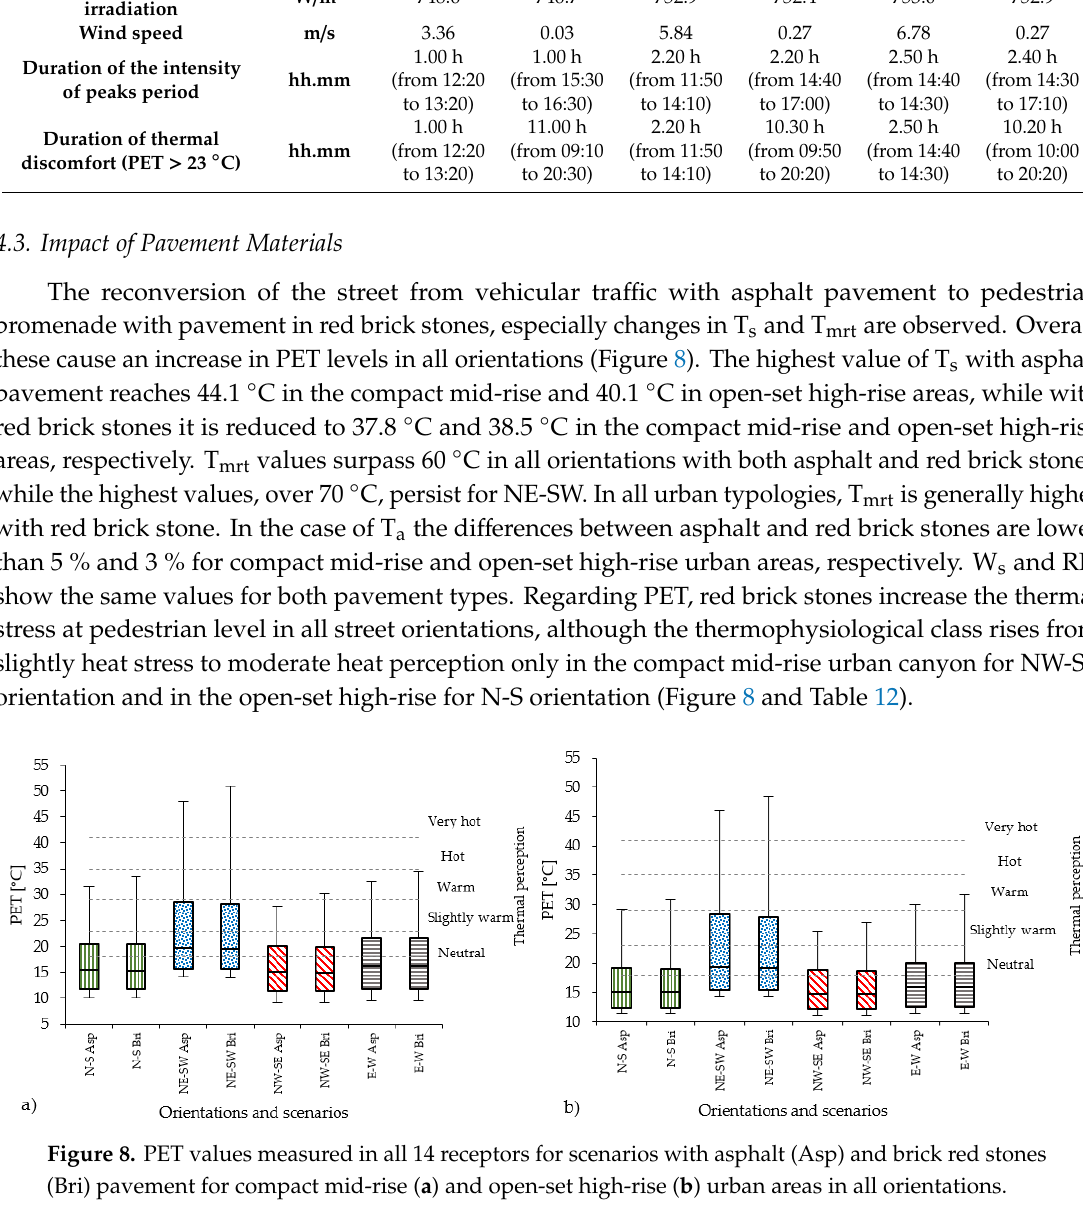
Figure 7. The hourly evolution of the typical trend (R04) of short-wave direct (Sw dir) and diffuse (Sw dif) irradiation and the W s at pedestrian level within the ( a ) compact low-rise, ( b ) compact mid-rise